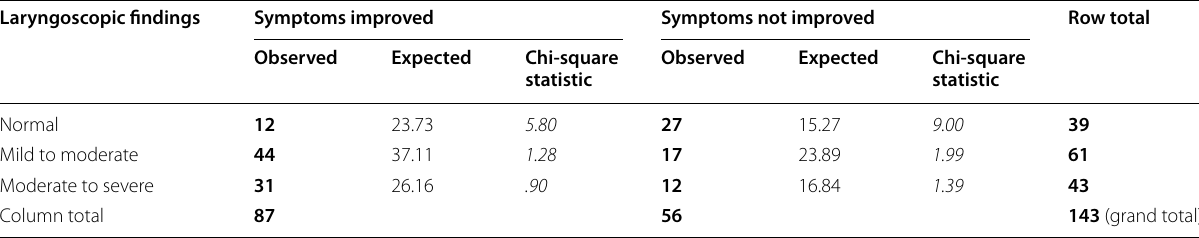
The chi-square statistic is 20.3515. The p -value is .000038. The result is significant at p <